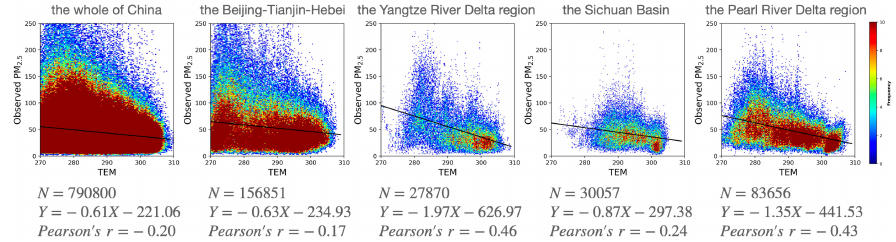
Figure 5. The density scatterplots of temperature (TEM) and observed PM 2.5 in the whole of China, the Beijing-Tianjin-Hebei, the Yangtze River Delta region, the Sichuan Basin and the Pearl River Delta region. In each subfigure, statistical results are attached with the linear regression relation, the number of samples (N), the Pearson correlation coefficient (Pearson’s r).